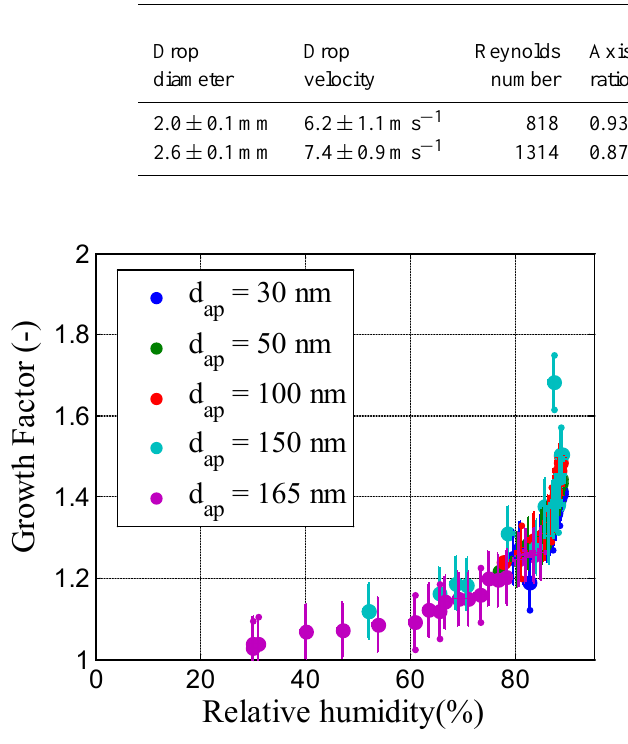
Figure 4. Growth factor (GF) of fluorescein aerosol particles mea- sured using an HTDMA (according to Villani et al., 2008, the RH Figure 1. Growth factor (GF) of fluorescein aerosol particles measured using an HTDMA and GF uncertainties are respectively less than 1% and (according to Villani et al. , 2008 the RH and GF uncertainties are respectively less than 1 % and 0.07)